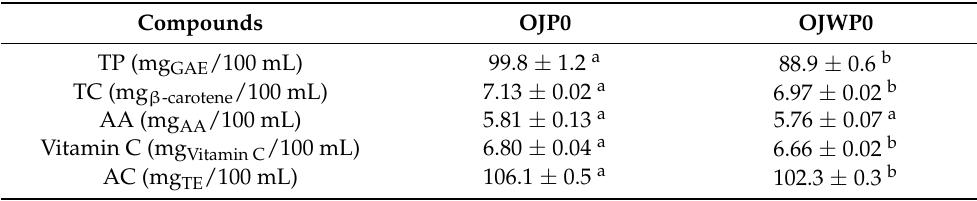
Table 2. Mean values (and standard deviations) of total phenols (TP), total carotenoids (TC), ascorbic acid (AA), and vitamin C content of pasteurized orange juice with and without RMD addition, OJP0 and OJWP0, respectively (control